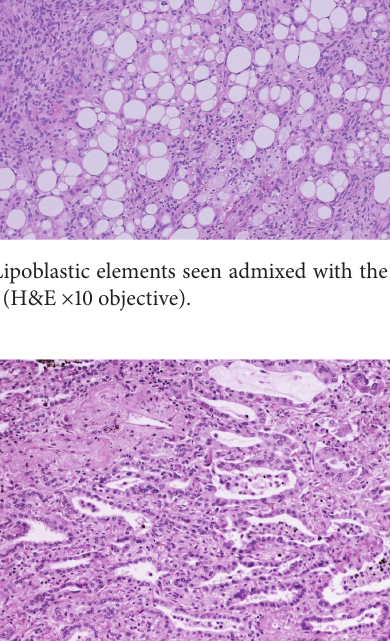
Figure 1: Lung parenchyma showing infiltration by biphasic malig- nant tumour which in areas shows lipoblastic elements (H&E × 5 objective).